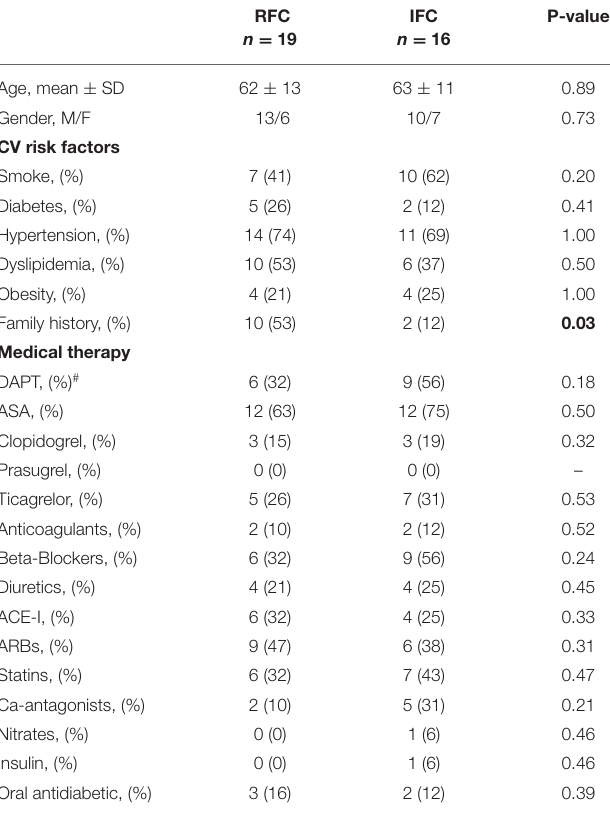
TABLE 2 | Main clinical characteristics of patients with RFC and with